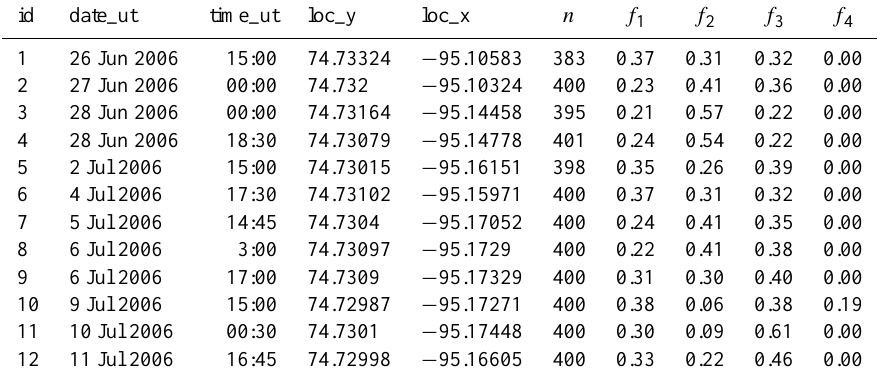
Table 2. Transect measurements of surface type fractions in the Canadian Arctic, POL-ICE 2006, where the relative surface type fractions are as follows: f 1 is the snow/bare ice, f 2 – melt pond, f 3 – mixed cover, f 4 – over-frozen melt pond. id